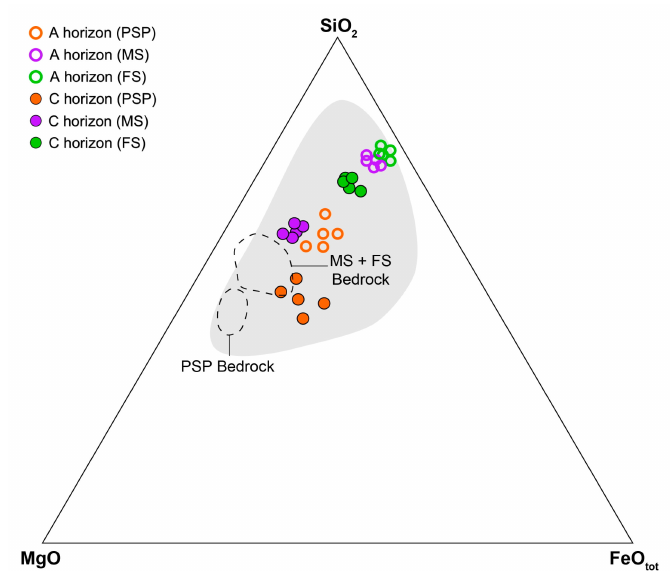
Figure 5. Ternary diagram of MgO–SiO 2 –FeOtot for the studied soils. The gray field corresponds to the composition of ultramafic soils worldwide (data from [5,9,10,16,28,52,70–74]). Dashed fields correspond to the composition of bedrock of the studied soils (data from [69]).